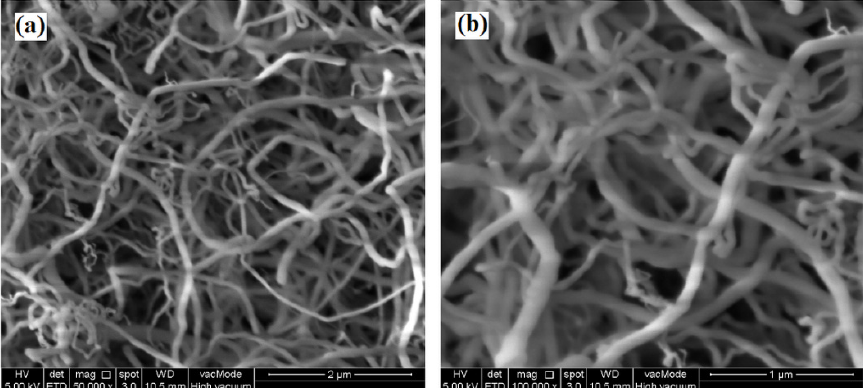
Figure 1. FESEM shows the apparent structure and morphology of the as-synthesized 10 B-enriched fibers of h-BN ( 10 BNNFs) in ( a ) low and ( b ) higher magnification. fibers of h-BN ( 10 BNNFs) in ( a ) low and ( b ) higher magnification.